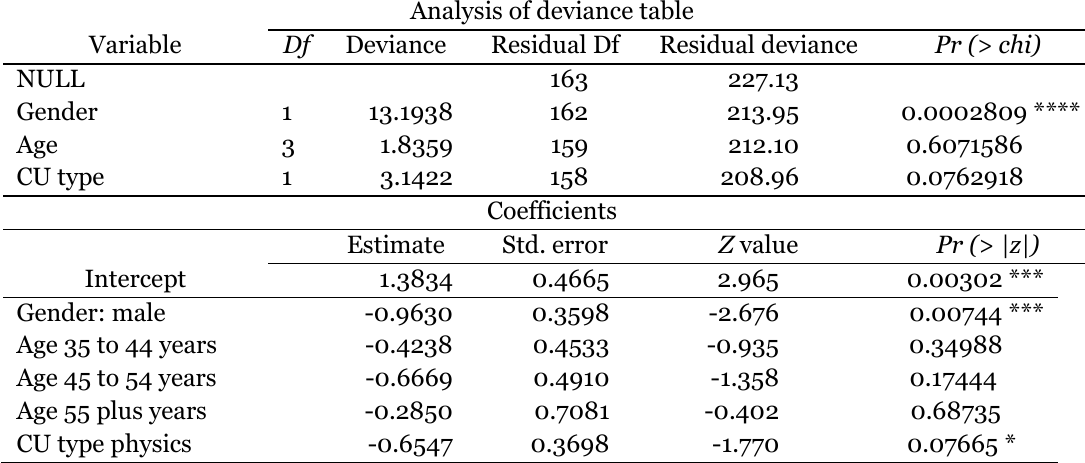
Significance of Using Facebook